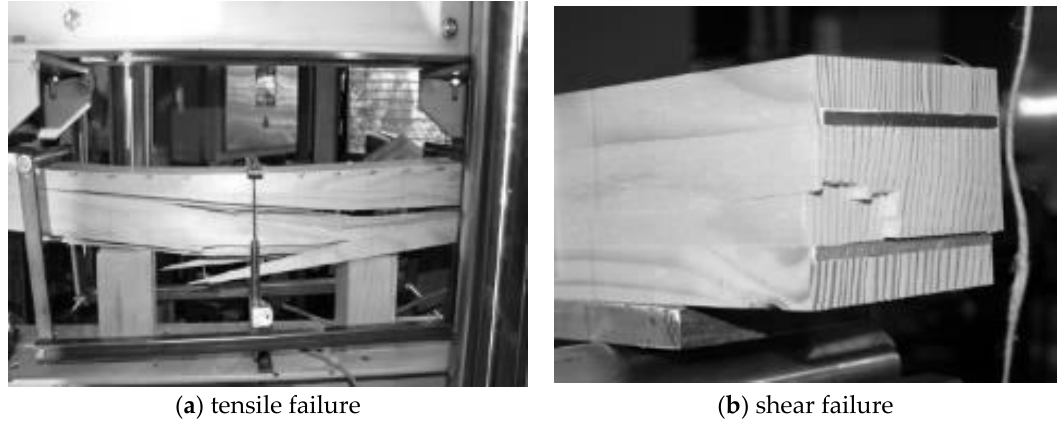
Figure 10. Typical failure mechanisms of specimen types A, C, D ( a ) and specimen type B ( b ).